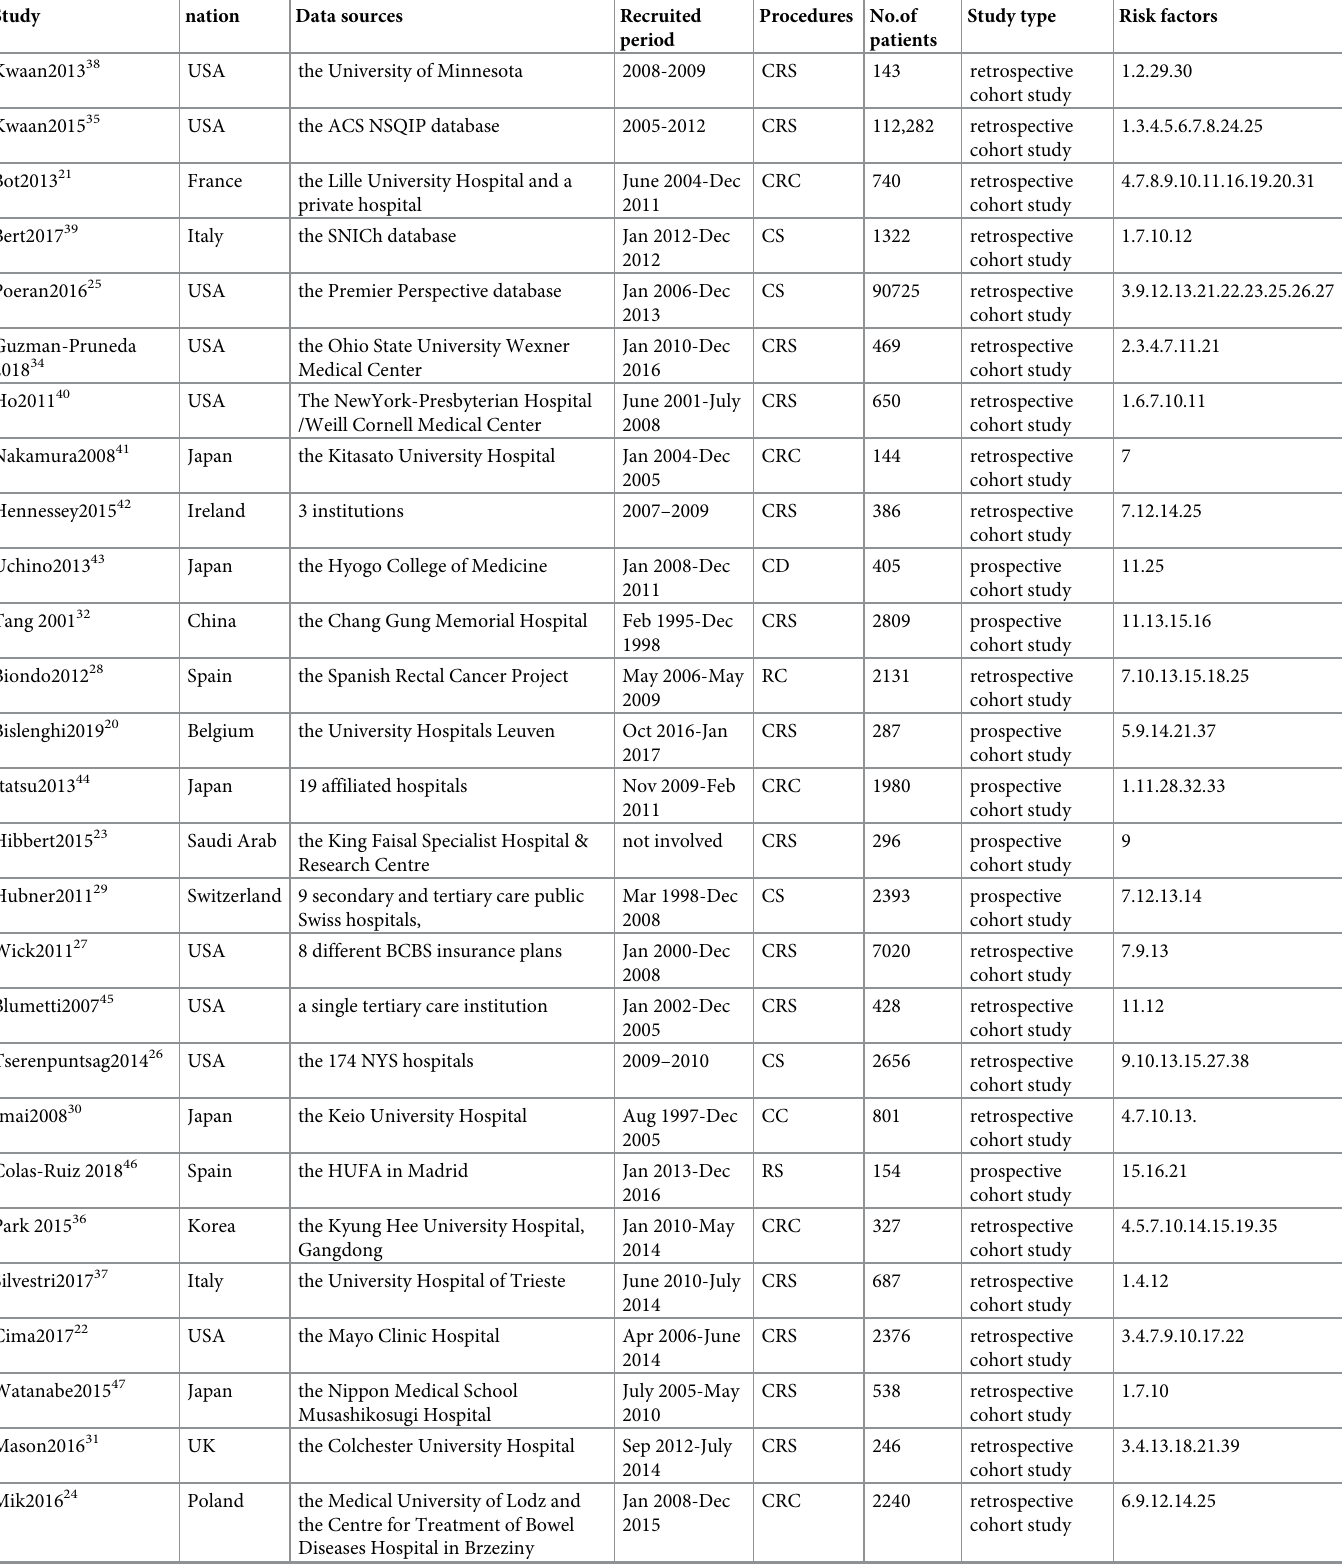
Table 1. General characteristics of the included studies in the